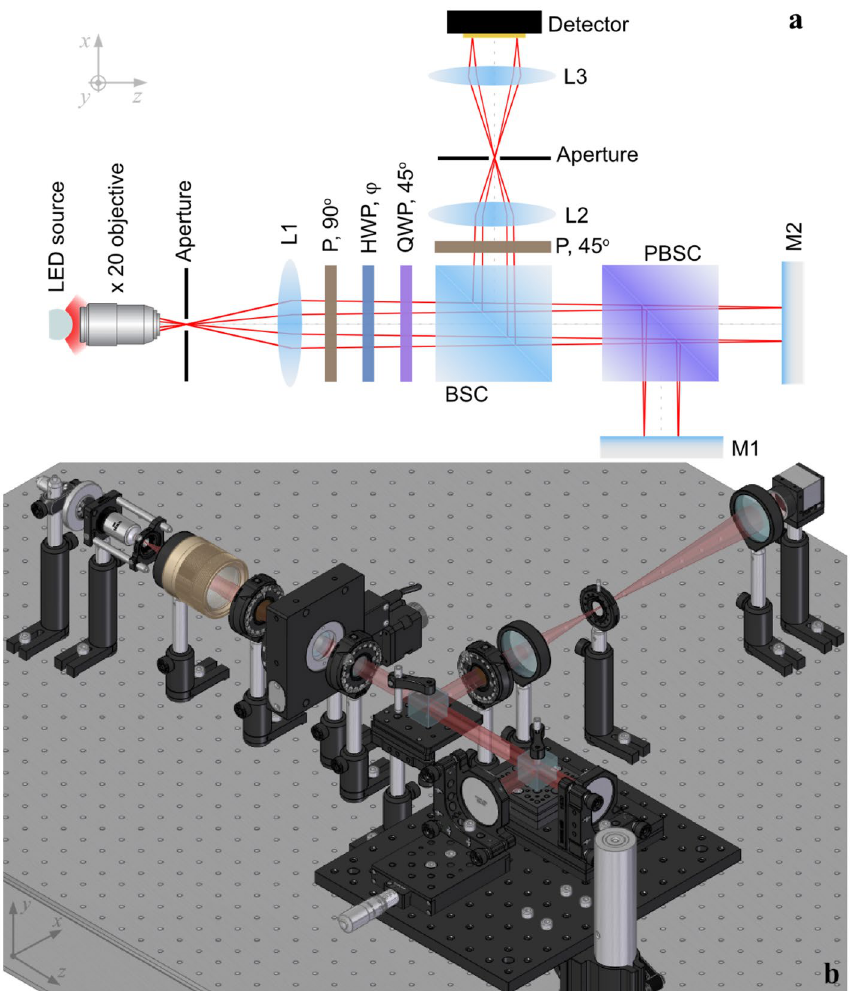
Figure 1. Experimental setup—( a ) layout, ( b ) CAD design: light source, microscope objective, aperture, collimating lens (L1), linear polarizer aligned vertical to the optical table (P, 90°), half-wave plate with variable azimuth angle (HWP, φ), quarter-wave plate fixed azimuth angle at 45° (QWP, 45°), beam splitter cube (BSC), polarizing beam splitter cube (PBSC), mirrors (M1 and M2), linear polarizer at 45° (P, 45°), relay optics (L2 and L3) and